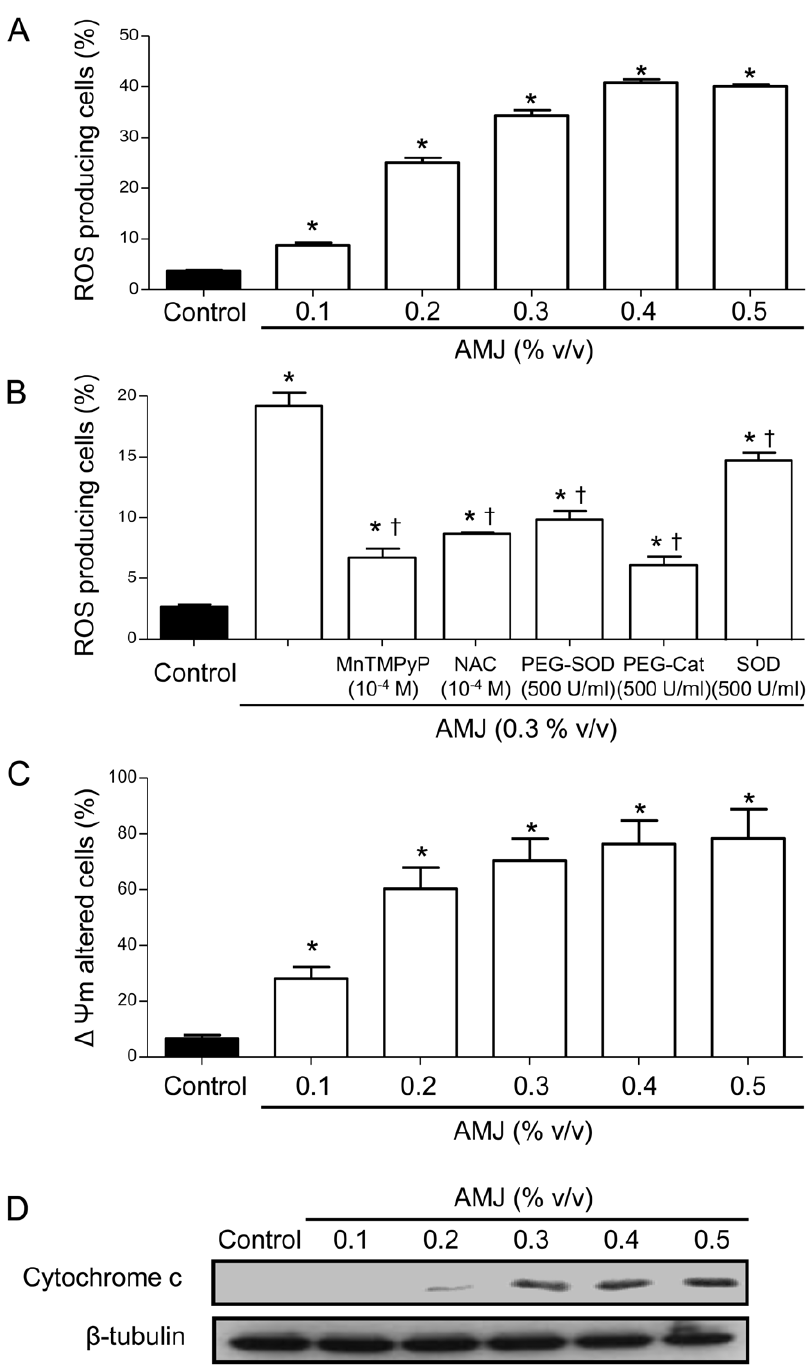
Figure 3. AMJ induced a pro-oxidant response and altered the DY m in Jurkat cells. Cells were exposed to increasing concentrations of AMJ for 24 h. (A) and (B) The formation of ROS was assessed by flow cytometry after incubation with the redox-sensitive fluorescent probe DHE. Cells were exposed to antioxidant treatment as indicated 30 min before the addition of AMJ. (C) Changes in the DY m were assessed by flow cytometry using the fluorescent probe DiOC6. Values are shown as means 6 S.E.M. (n=3); *, P , 0.05 versus control; { , P , 0.05 versus AMJ treatment. (D) The level of cytochrome c in the cytosolic fractions of Jurkat cells was assessed by Western blot analysis. Similar findings were observed in three independent experiments. doi:10.1371/journal.pone.0032526.g003 have been shown to have pronounced anticancer effects both in in promyeloblastic leukemia HL-60 cell line [30]. An extract of vivo and in vitro studies on various colorectal cancer models mulberry fruit also induced human glioma cell death and reduced [9,10,11], and leaves extracts of Aronia melanocarpa have been glioma tumor growth in vivo [31]. Moreover, black raspberry and shown active on a non-solid tumor cell line, the p53-null blueberry reduced estrogen-induced mammary tumorigenesis